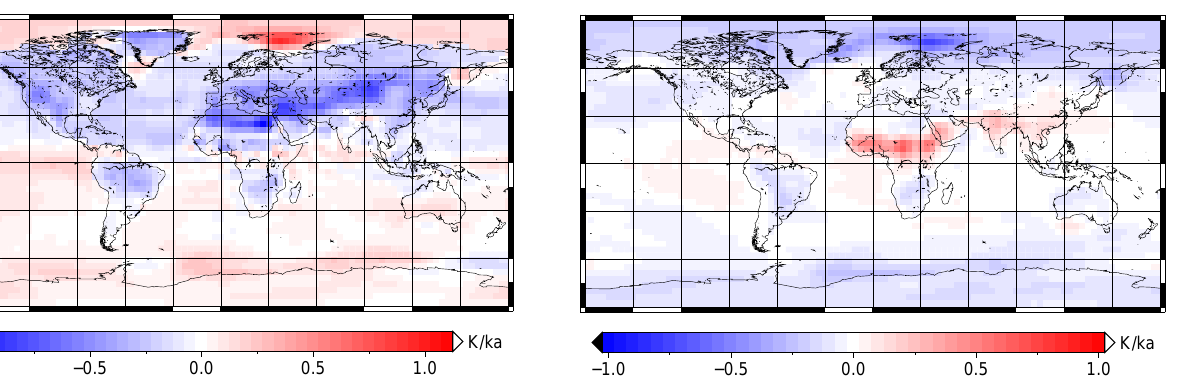
is 30 W m − 2 (6.6 %) and 12.66 W m − 2 (16 %) for the net sur- face shortwave